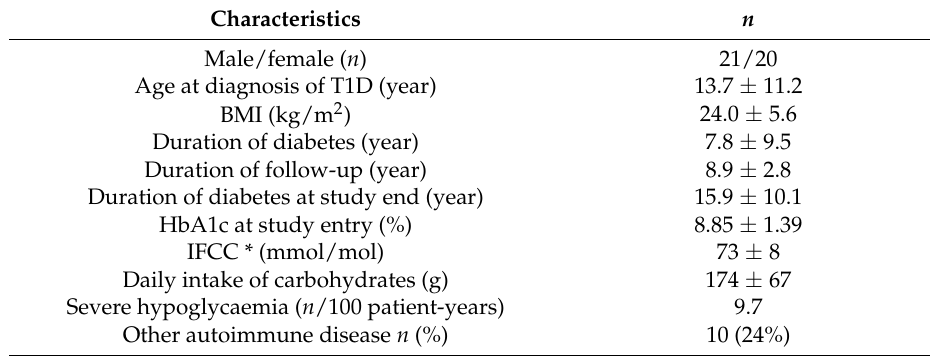
Table 1. Baseline characteristics of people with type 1 diabetes completing the study with treatment change to CSII and introduction of CGMS ( n = 41).